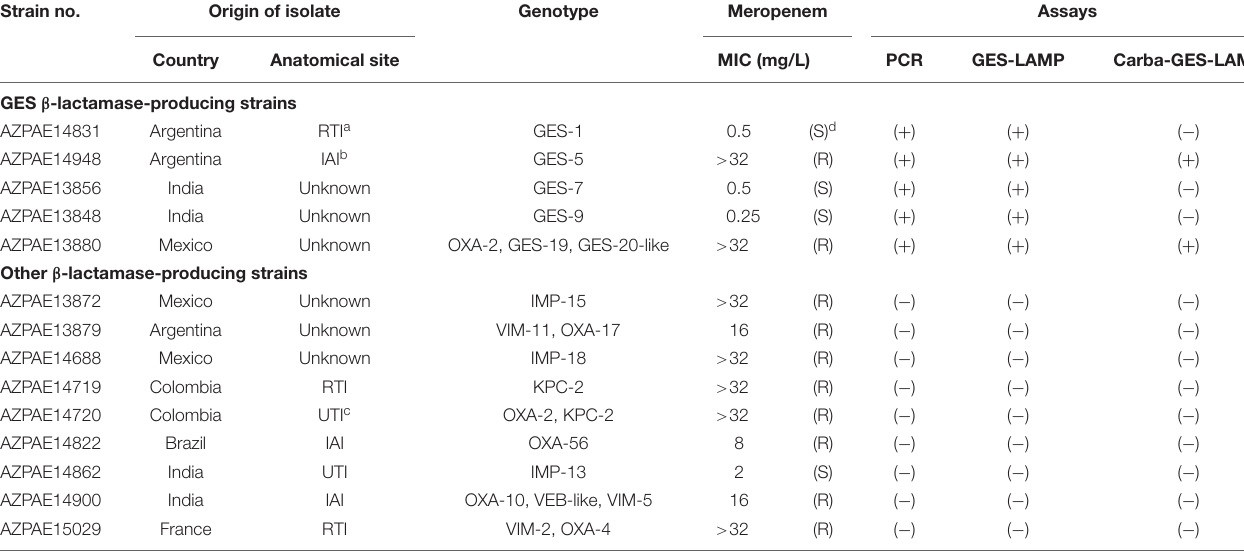
TABLE 2 | Clinical Pseudomonas aeruginosa isolates evaluated. Strain no.